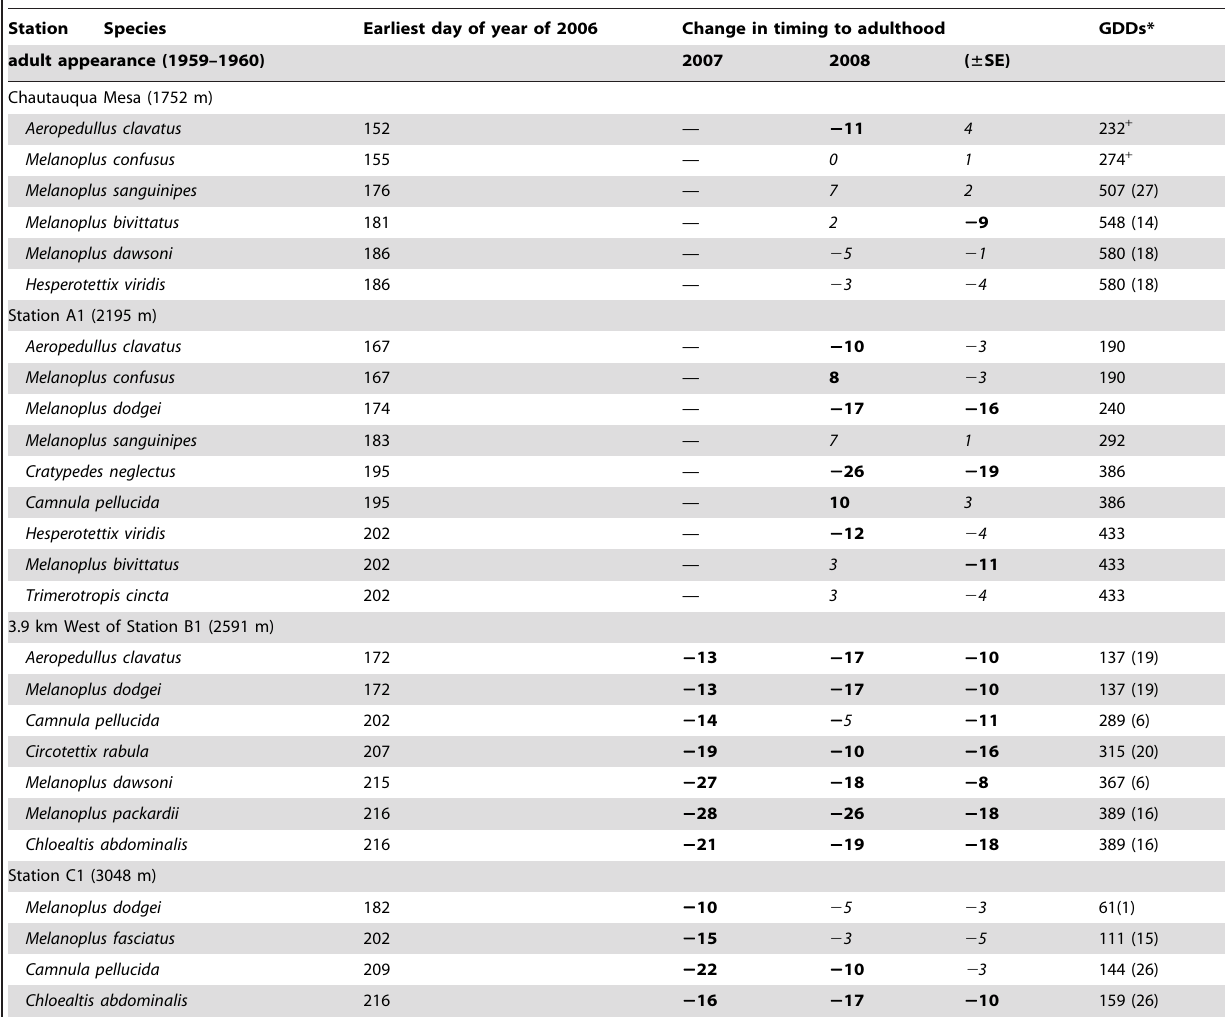
Table 2. Grasshopper communities, phenological advancements and